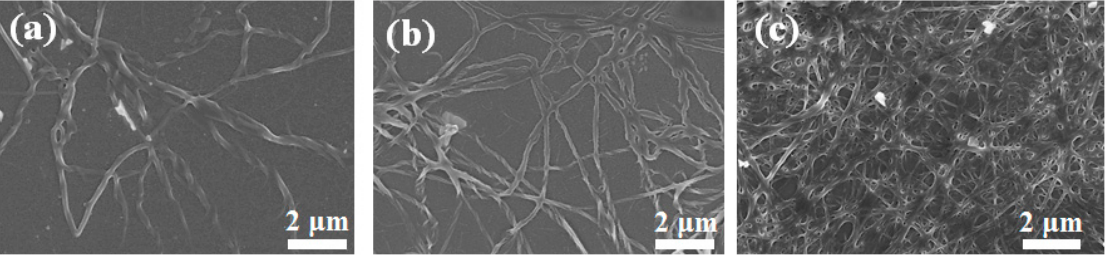
Figure 2. SEM images of rat tail collagen (200 μ g/mL) fibers formed in CNC/Col hydrogel assembling process in ( a ) 10 min, ( b ) 30 min and ( c ) 60 min.